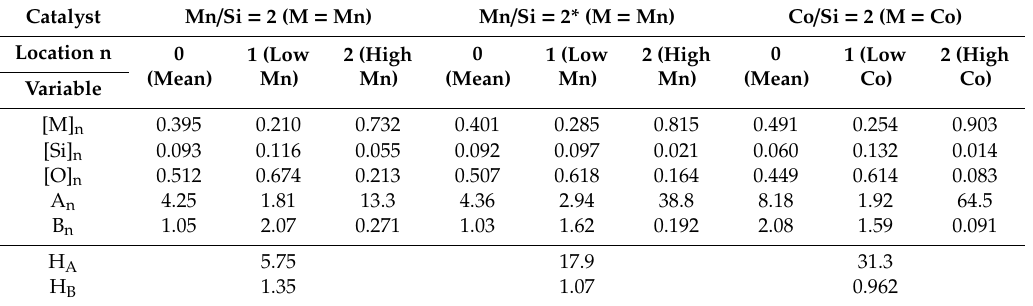
Table 10. Characteristics of silica supported fresh manganese catalyst after synthesis with plasma generation (Mn / Si = 2) and following further microwave irradiation at 1800 W (Mn / Si = 2*) together with the results for Co / Si = 2 catalysts for